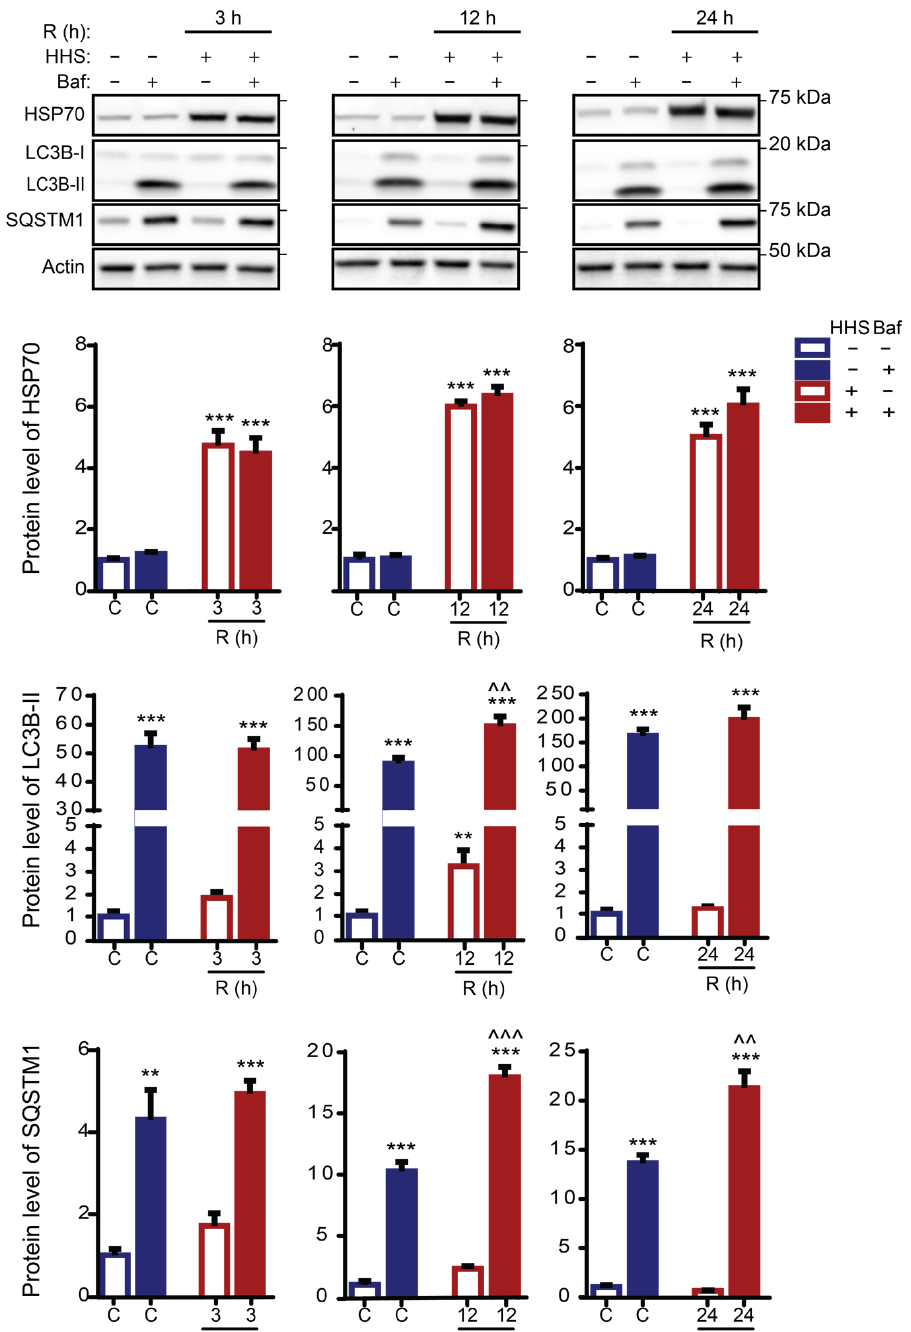
Figure 4. Hormetic heat shock induces autophagy. ARPE-19 cells were exposed initially for 6 h to 50 nM Bafilomycin (Baf); then, cells were treated without HHS (–) or with 30 min HHS (+) at 42 °C, followed by recovery at 37 °C in the presence of Baf. Immunoblot analysis of HSP70, LC3B-II, and SQSTM1 are illustrated with representative images. C stands for Non-HHS/Non-Baf and Non- HHS/Baf treated cells. R shows the post-HHS time of recovery at 37 °C. The quantitative analysis was corrected to Actin as a loading control and normalized to Non-HHS/Non-Baf as the control. Data are represented as mean ± SEM ( n = 3), followed by one-way ANOVA by Sidak test (** p < 0.01 and *** p < 0.001 vs. C, ˆˆ p < 0.01, and ˆˆˆ p < 0.001 vs.